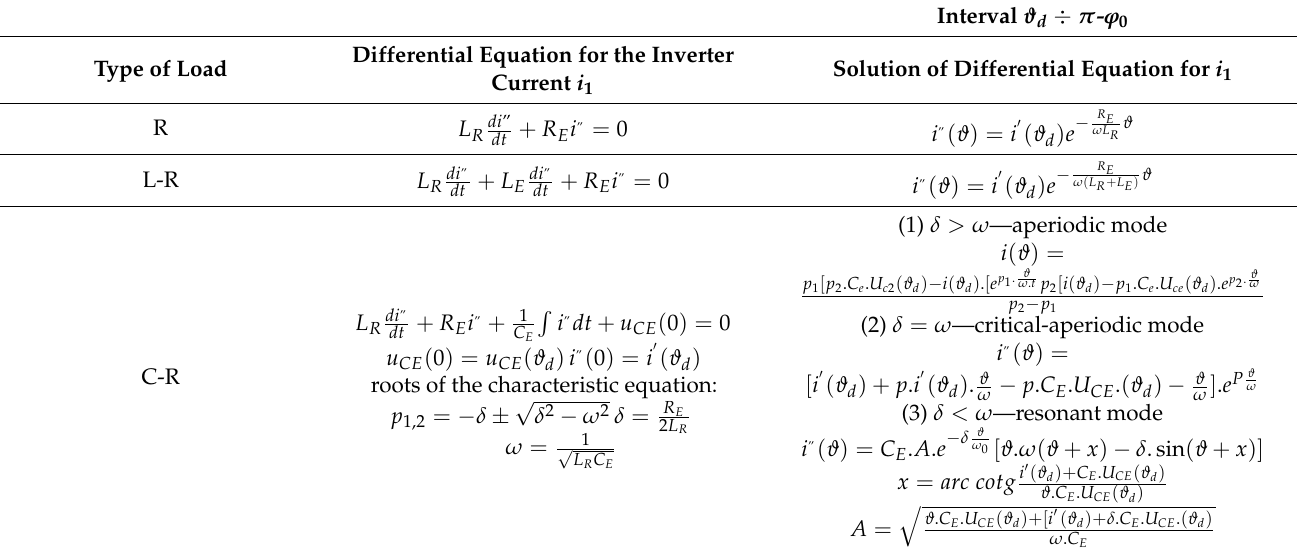
Table 2. Mathematical expressions describing the second interval of the operation of the